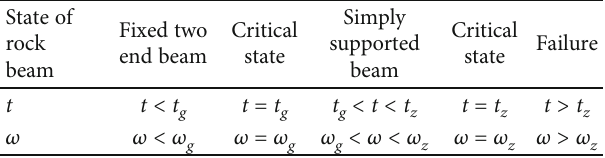
Figure 3: Strike direction main roof force model. Table 1: Criteria for judging roadway roof